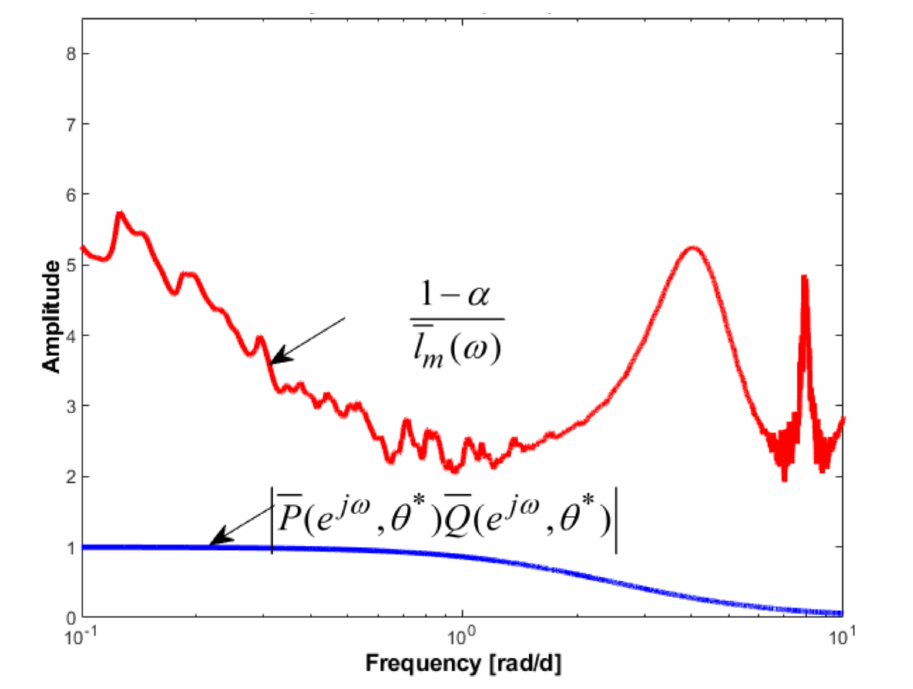
Figure 13. Checking the robust stability of the